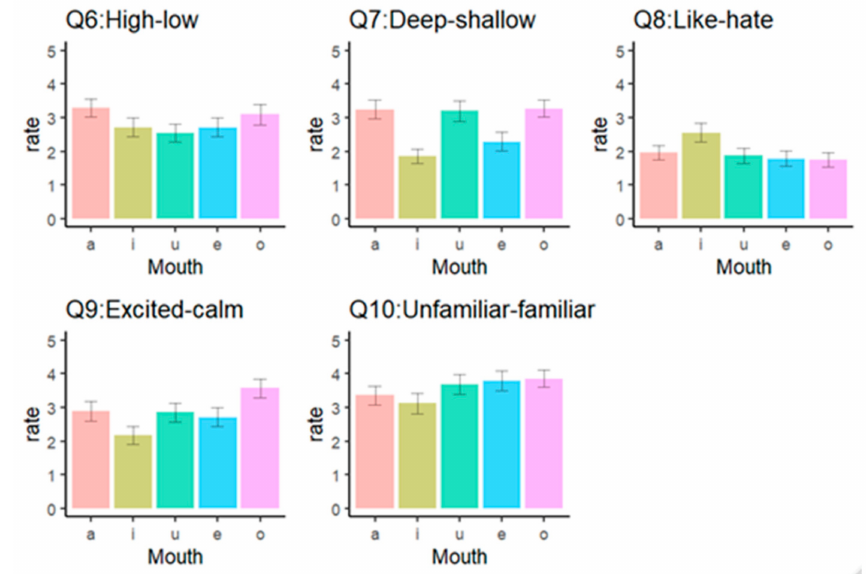
Figure 3. Results of the analysis of Q6 (height), Q7 (depth), Q8 (preference), Q9 (arousal), and Q10